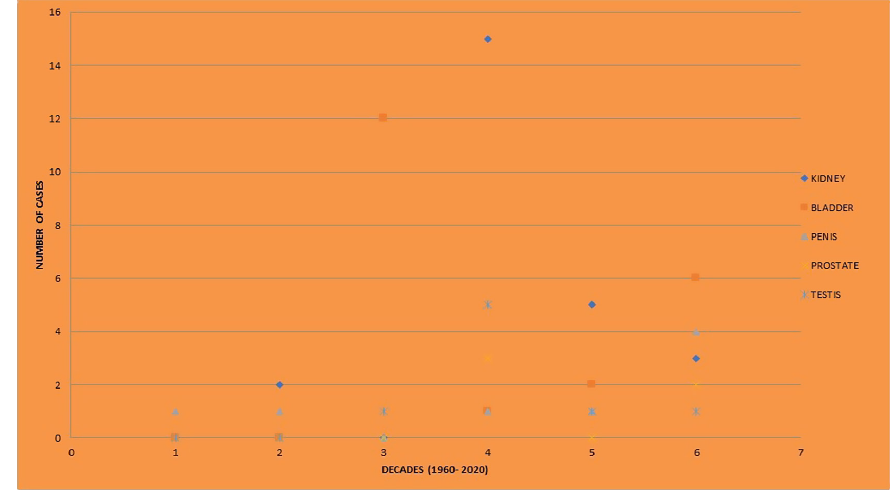
poor.Figure 2. Decade-wise distribution of cases of urological malignancies with hypercalcemia, as reported in the literature. Y Axis: Numbers of cases of an individual urological malignancy with hypercalcemia. X Axis: Decades: 1 = 1960-1970; 2 = 1970-1980; 3 = 1980-1990; 4 = 1990-2000; 5 = 2000-2010; 6 = 2010-2020; 7 =